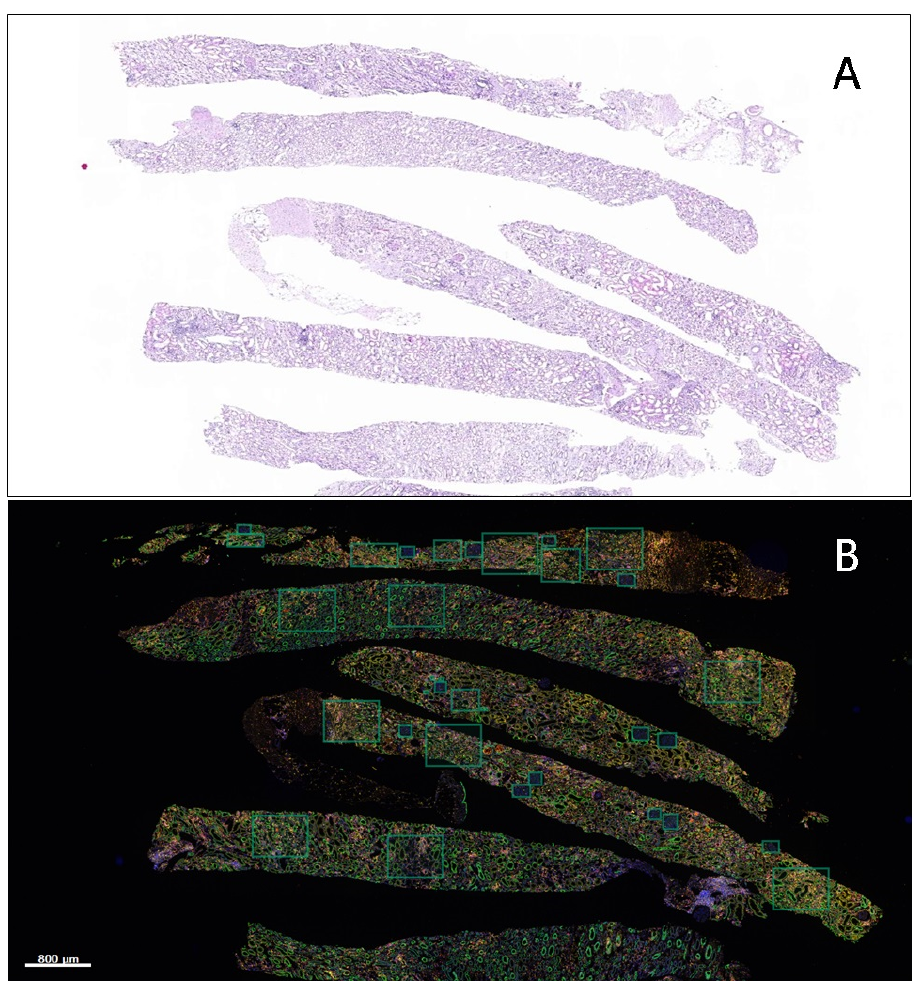
Figure 2. Selection of regions of interest (ROIs). ( A ) Acute T-cell-mediated rejection samples were stained with PAS; ( B ) the scanned images show multiplex immunofluorescence staining. ROIs are marked with rectangles. Cell counting was independently performed within these ROIs. The total number of cells was assessed per ROI.